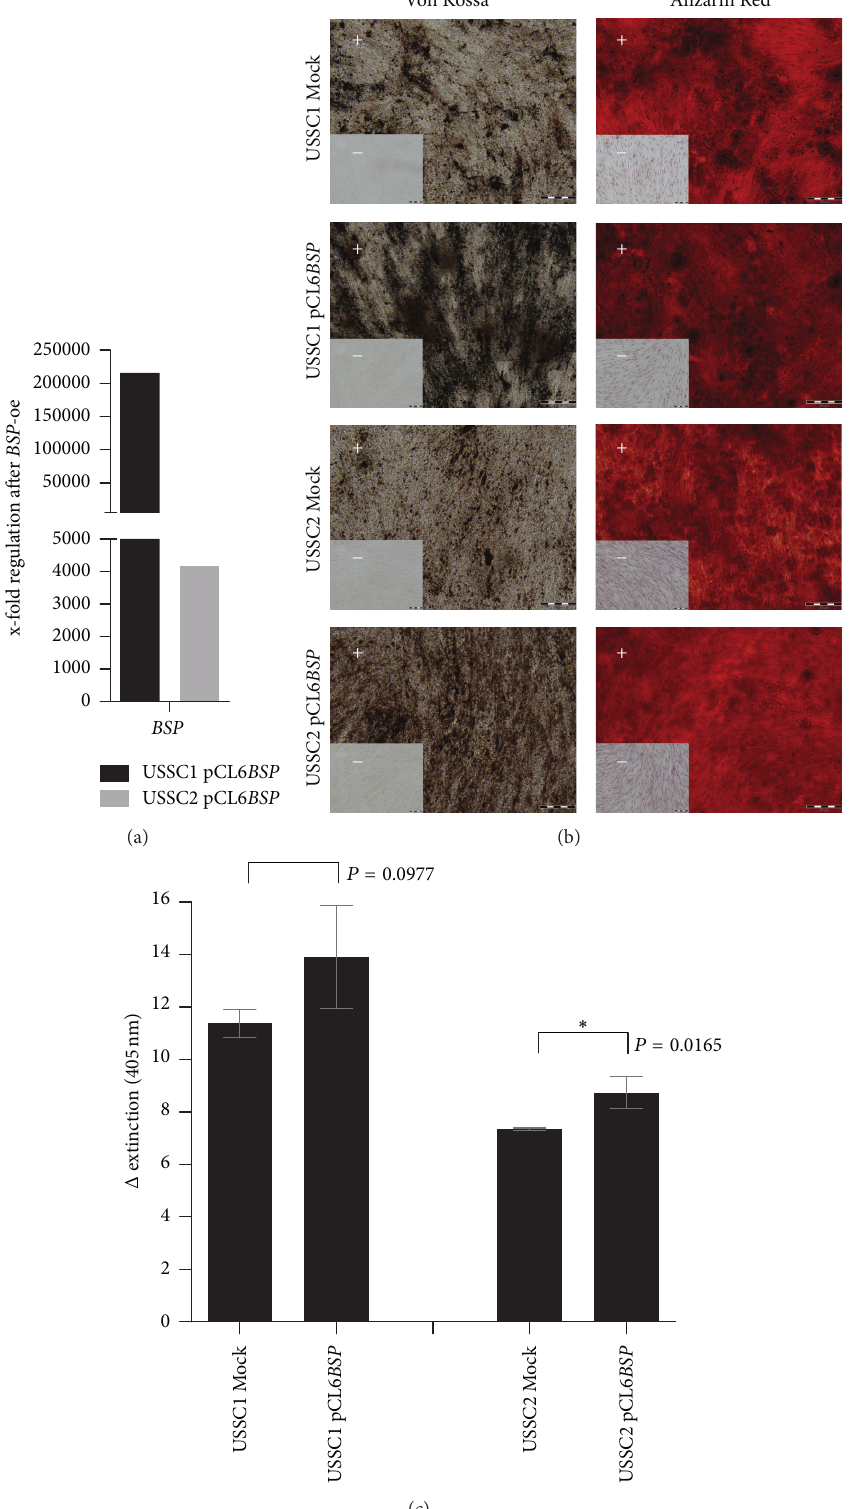
Figure 3: Lentiviral overexpression of BSP in two USSC cell lines. (a) Quantitative RT-PCR analysis of BSP gene expression (in undifferentiated cells) after overexpression in relation to the control cells (Mock). RPL13A was used as housekeeping gene. (b) Osteogenic differentiation experiments in overexpressed and Mock cells. After 14 days of differentiation, Von Kossa and Alizarin Red S staining were performed in the induced (+) and noninduced ( − ) cells. Mineralized areas are stained in brown/black or red, respectively. Scale bar: 200 𝜇 m. The results were confirmed in independent experiments; representative histological staining and the subsequent quantification of the bound Alizarin Red S-dye (c) are depicted. ∗ 𝑃 = 0.01 to 0.05, significant (unpaired 𝑡 -test). BSP : integrin-binding sialoprotein RPL13A : ribosomal protein